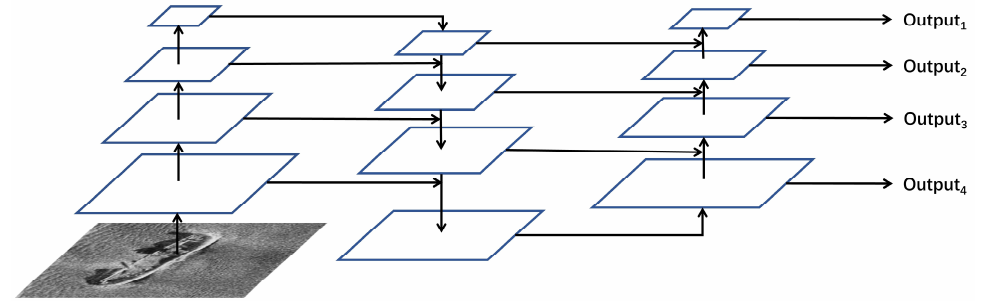
Figure 4. Illustration of a PAN (parallelograms are feature maps).